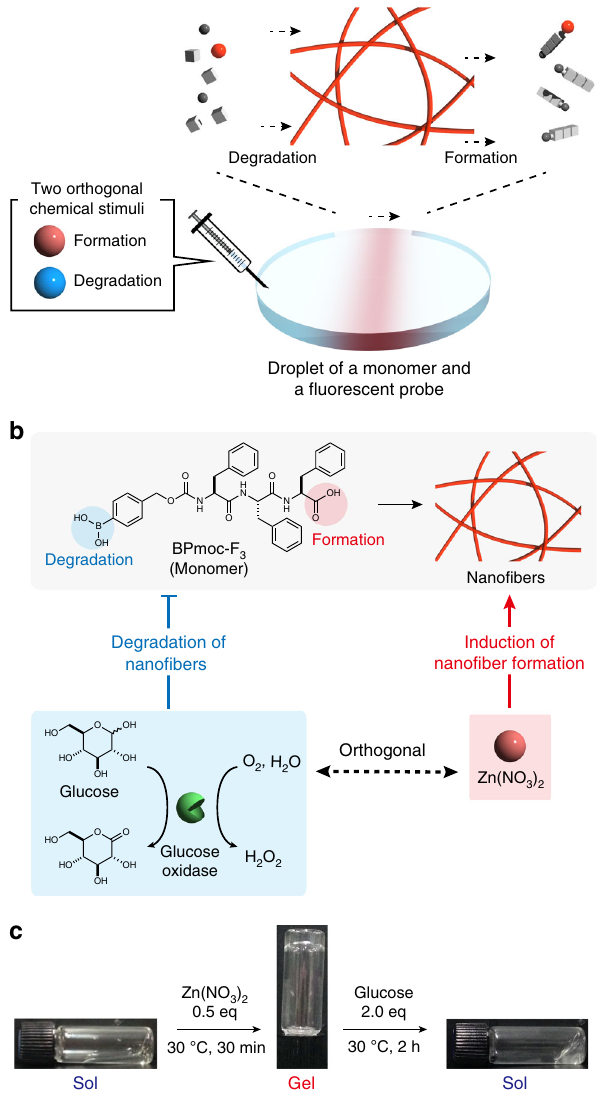
Fig. 1 Design of a propagating wave of supramolecular nano fi bers. a Schematic illustration of a propagating wave comprising